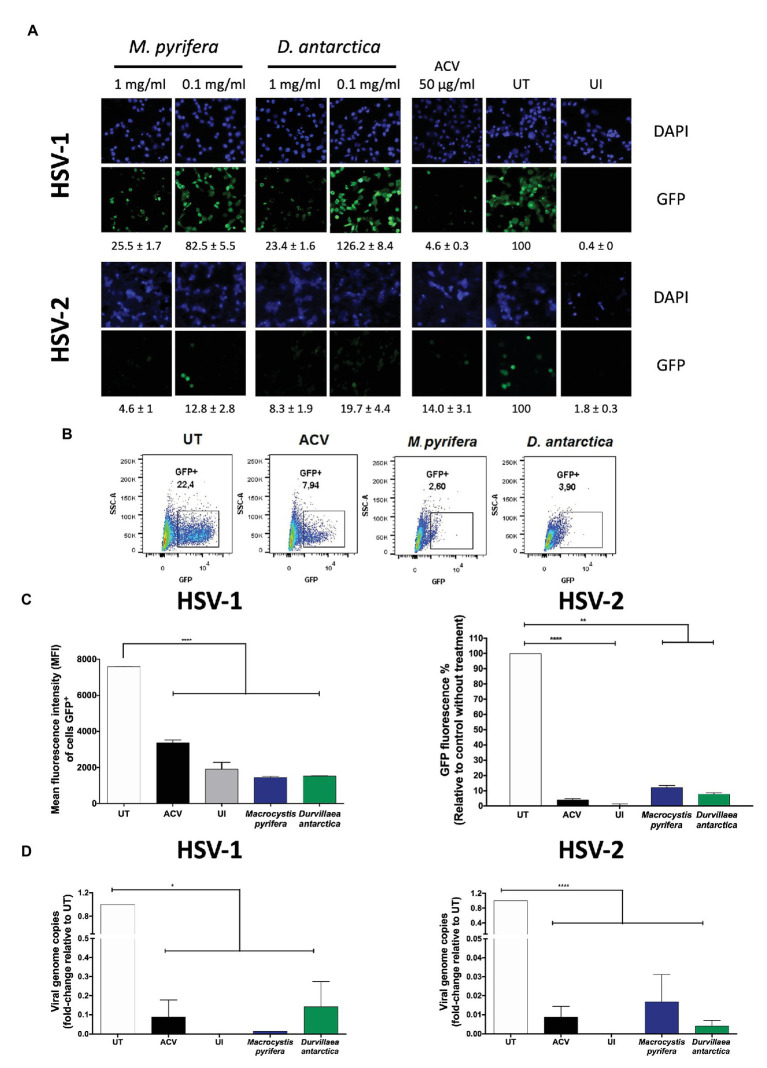

In vitro herpes simplex virus (HSV) antiviral activity of the M. pyrifera and D. antarctica algae extracts. HeLa cells were pre-treated 1 h with the aqueous extracts, then infected with HSV at an multiplicity of infection (MOI) 1, and 1 h post-infection (hpi) treated again with the algae extracts either, for 24 h [virus-derived green fluorescent protein (GFP) fluorescence] or 12 h (virus replication). As a control, acyclovir (ACV, 50 μg/ml) was applied immediately after infection and left for the complete duration of the assay. (A) Representative fluorescence microscopy images of virus-derived GFP fluorescence (green) in cells treated with the M. pyrifera or D. antarctica algae extracts at 1 or 0.1 mg/ml and infected with HSV-1 (upper set of panels) or HSV-2 (lower set of panels). The extracts were present during the complete duration of the assay after infection. Cell nuclei were counterstained with DAPI (blue). GFP-derived fluorescence was quantified using ImageJ software. Data are means ± SEM of three different image fields. Representative images are shown. (B) Representative FACS plots showing the frequency of GFP-positive cells infected with HSV-1 and treated with the algae extracts. ACV, acyclovir; UT, untreated. (C) Left: mean fluorescence intensity of GFP-positive cells infected with HSV-1 (determined by flow cytometry 24 hpi) treated with M. pyrifera (blue bars) or D. antarctica (green bars) at 1 mg/ml for the complete duration of the assay after infection. Right: GFP fluorescence of HSV-2-infected cells (determined with a multi-mode reader cytometry 24 hpi) treated with the M. pyrifera (blue bars) or D. antarctica (green bars) extracts at 1 mg/ml for the complete duration of the assay after infection. (D) Viral genome copies (UL30 gene) were determined by quantitative PCR (qPCR) 12 hpi in cells infected with HSV-1 (left graph) or HSV-2 (right graph) at an MOI 1 and treated with the M. pyrifera (blue bars) or D. antarctica (green bars) extracts at 1 mg/ml for the complete duration of the assay after infection. UT, untreated cells; UI, uninfected cells. Data shown correspond to means ± SEM of three independent experiments for (A–C) and two experiments for (D). The data were analyzed using one-way ANOVA and Dunnett’s multiple comparisons test. ****p < 0.0001; ***p < 0.001; **p < 0.01; and *p < 0.05.